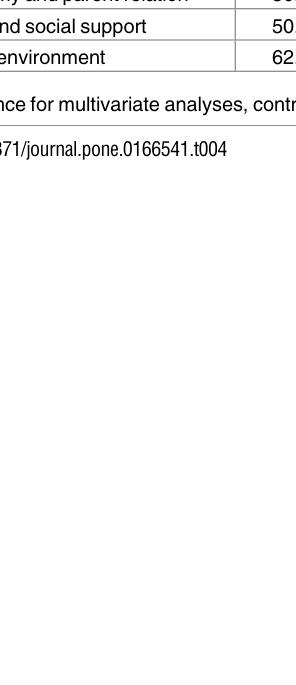
Table 5. Multivariate analyseson KIDSCREEN in specific language-impairment (SLI) group, controlling for age and parental education. SLI ( n = 67) Physical well-being Psychological well- Autonomy and being parent